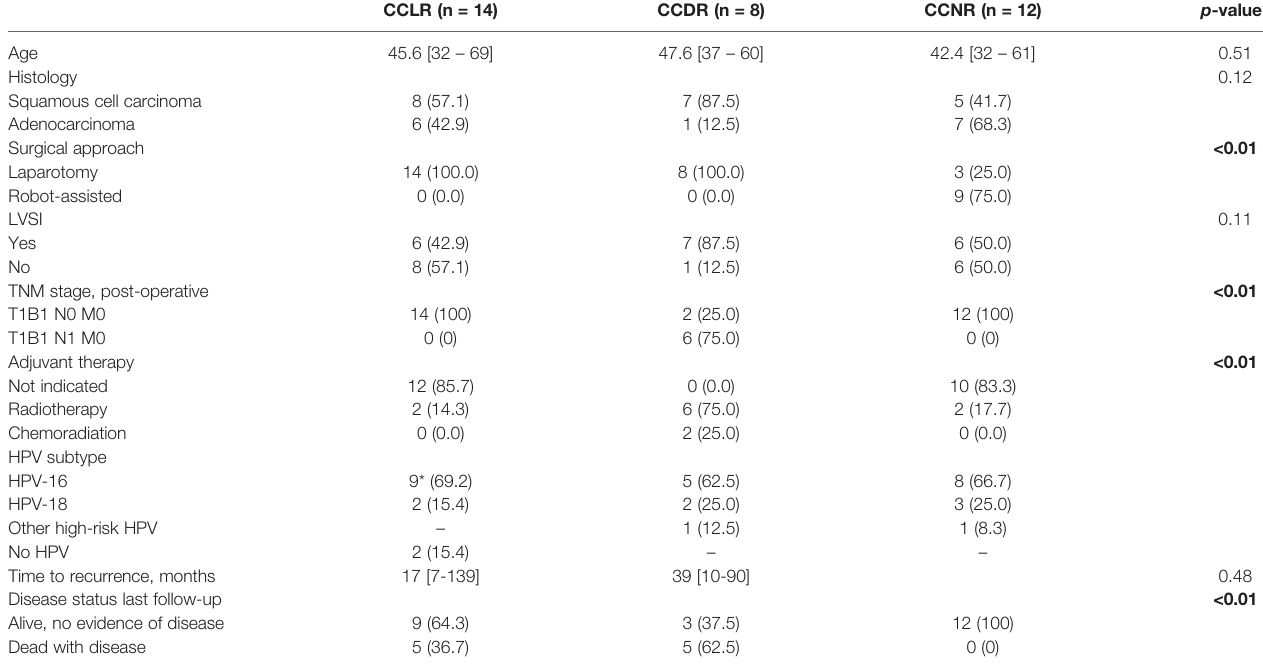
TABLE 1 | Clinicopathological